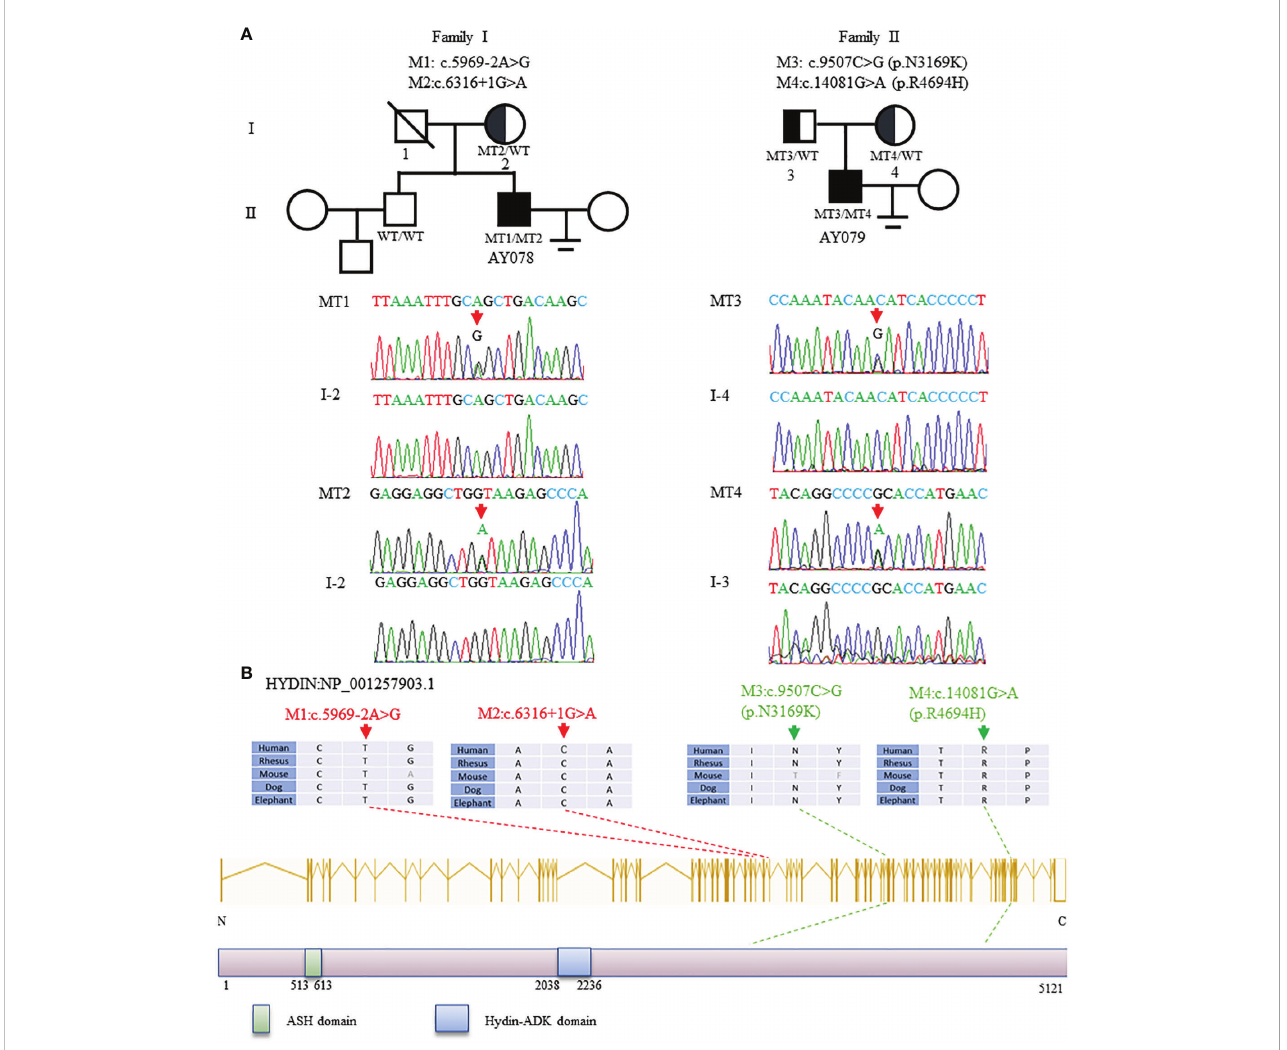
FIGURE 1 Identi fi cation and Bioinformation Analysis of HYDIN Mutations in Two unrelated families. (A) Two compound heterozygous mutations (M1-M4) of HYDIN were identi fi ed in two subjects with asthenoteratozoospemia. M2 of patient AY078 was inherited from heterozygous parents. Because the bioinformation of P1 ’ s father was incapable gained, M1 in AY078 was undetermined whether is inherited from his father or is new. M3 and M4 of patient 2 AY079 were obviously inherited from his heterozygous parents. The mutational positions were indicated with red arrow under Sanger sequencing results below. (B) Schematic representation of HYDIN exons and protein product. The conservation of variant residues among different species were veri fi ed by sequence alignment. The positions of variants were indicated in dots lines. Green square represents typical ASH (ASPH-SPD-2-Hydin) domain, blue square stands for Hydin-ADK domain, according to the NCBI